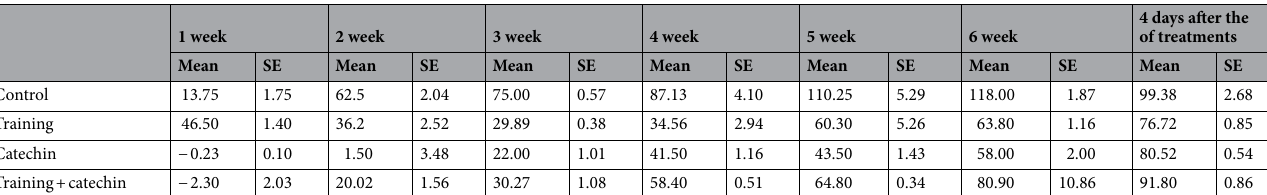
Table 4. SBP mean changes (mmHg) from basal values at the different times considered.